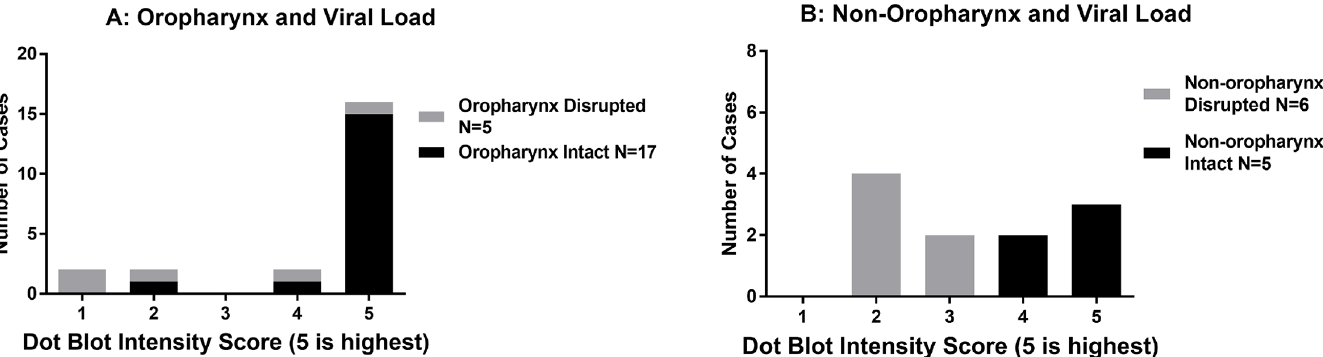
Fig 3. Low HPV16 DNA viral load correlates with E2 gene disruption in HPV16 positive OPSCC (A) and non-OP tumors (B). Viral load was determined by dot-blot intensity and scored from 1–5, 5 being highest. Scores are graphed separately across the x-axis. Samples with an intact HPV16 E2 gene are represented by the grey bars and samples with a disrupted HPV16 E2 gene are represented by the black bars.